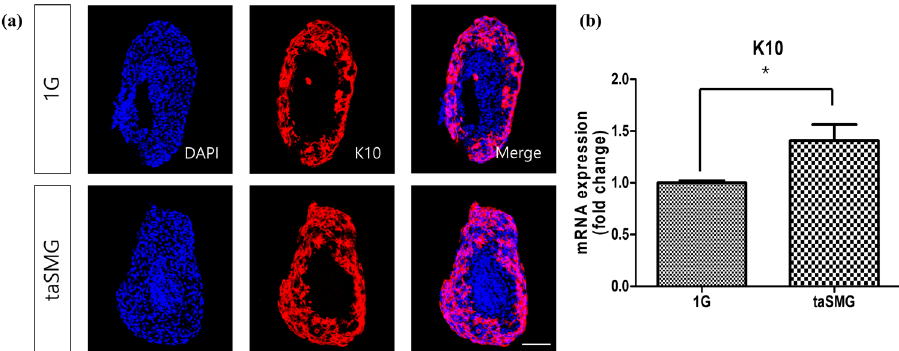
Fig. 4 Cytokeratin-10 (K10) expression of co-cultured spheroids under 1 G and taSMG. a K10 and DAPI staining showing the cytokeratin expression in keratinocyte layer and both nuclei of the keratinocyte layer and fi broblast core. Scale bar: 100 μ m. b qRT-PCR analysis of K10. Data represent the mean ± SEM ( n = 4, * p <